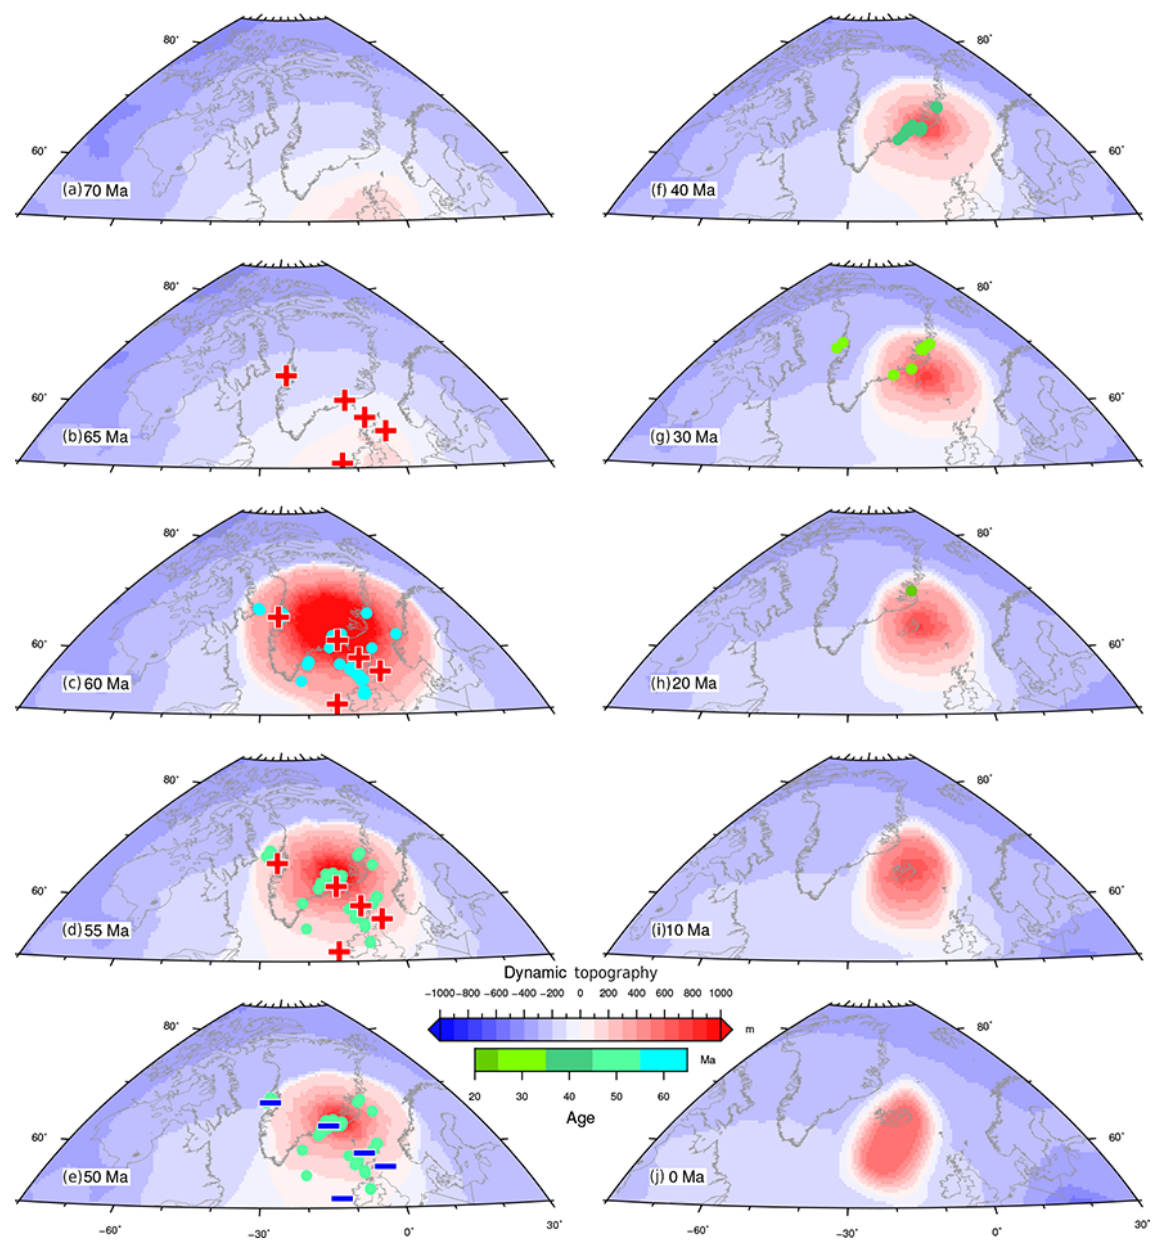
Figure 5. (a–j) Predicted Cenozoic North Atlantic dynamic topography in the mantle frame of reference extracted from the preferred reconstituted mantle flow model discussed in text. Circles colour-coded by age represent a compiled set of extrusive volcanics related to plume activities across the North Atlantic (Spice et al., 2016; Torsvik et al., 2001) in 10Myr intervals ( ± 5Myr for each reconstructed time) and reconstructed in the mantle frame of reference. Positive (red crosses) and negative (blue dashes) signs correspond to the timings in transient uplift and subsequent subsidence, respectively, based on published observations compiled in Figs.